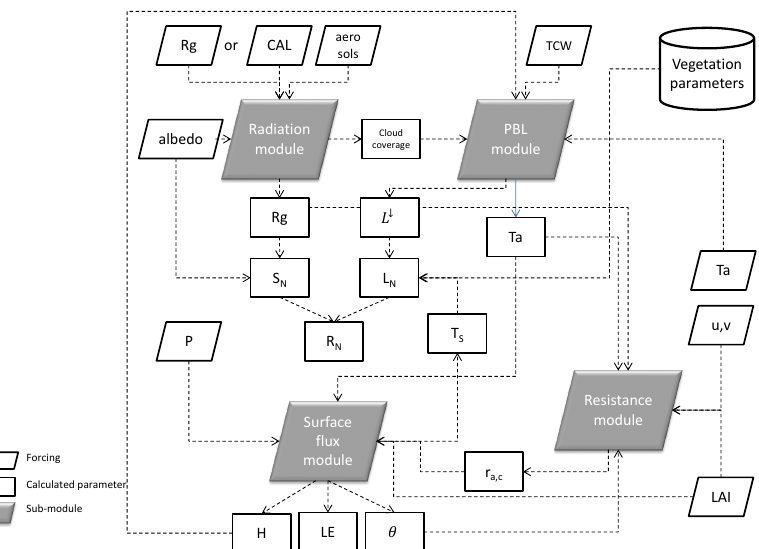
Figure 2. Forcing data and variable interdependencies in the HOLAPS model. Only major output variables are illustrated. Details for model formulations can be found in Appendix B.